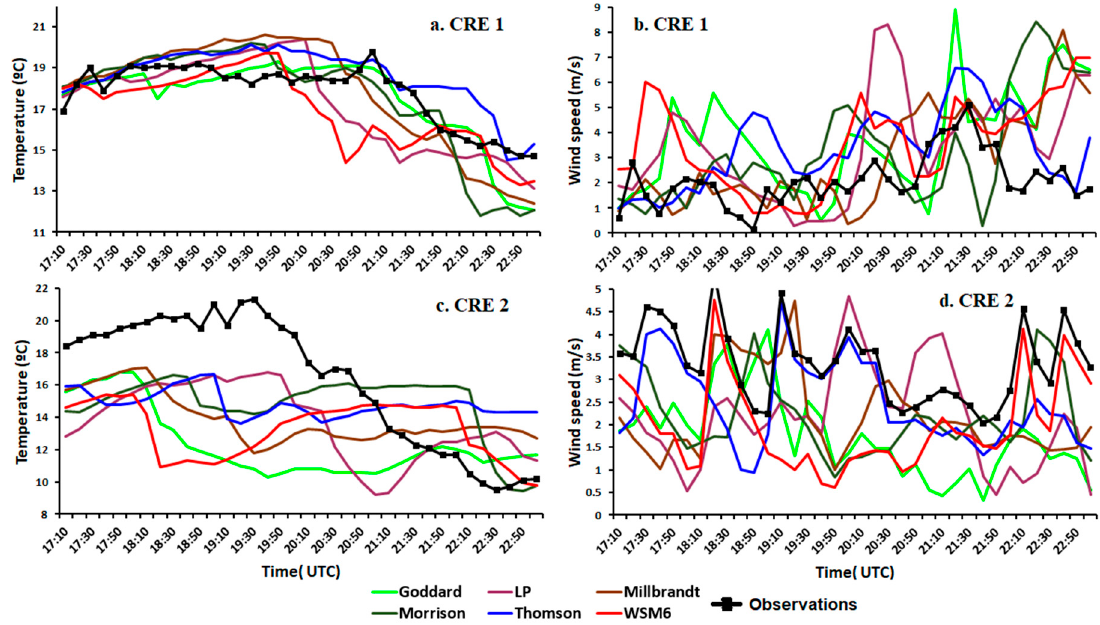
Figure 6. Time series of observed and simulated air surface temperature at 2 m and surface wind speed for six microphysics schemes for CRE1 and CRE2. The observations were made in HYO and the simulations represent the average of a 10 × 10 km box, centered in HYO. ( a ) Temperature, CRE1; ( b ). Wind speed, CRE1; ( c ). Temperature, CRE2; ( d ). Wind speed, CRE2.